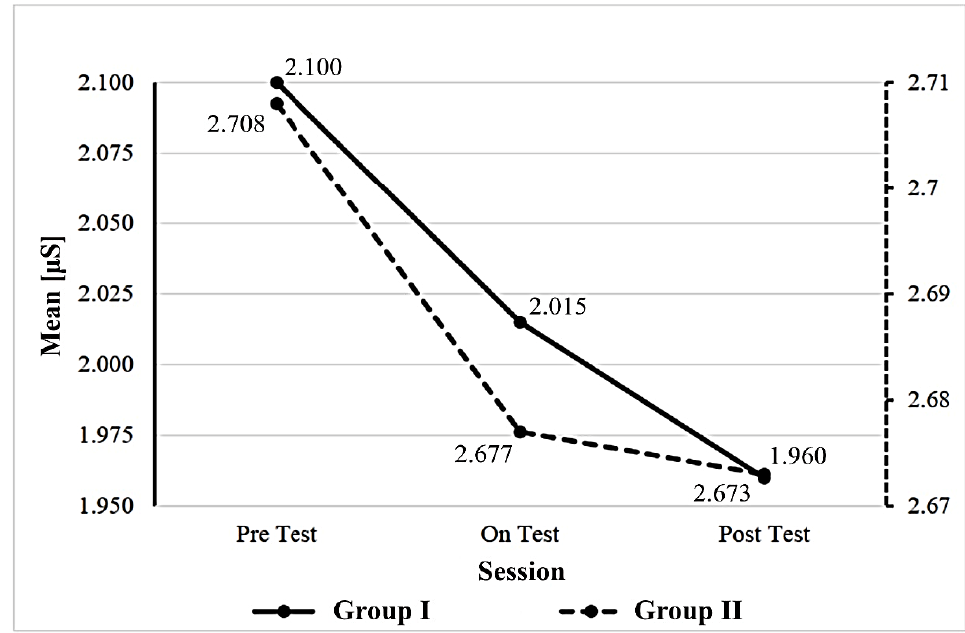
Figure 3. Improvement in stress response using galvanic skin response tool in group I (continuous line) and group II (dashed line) in a pre – on – post